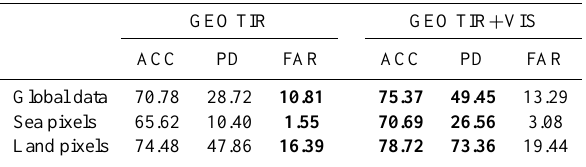
Table 3. Air quality monitoring results for GEO TIR and GEO TIR + VIS. For all the pixels of the red square domain (land and sea pixels together) in Fig. 2, the land pixels, and the sea pixels, we calculate the accuracy (ACC), the probability detection (PD) and the false alarm rate (FAR). See Sect. 3.2 for more details. Bold val- ues represent the best values in the comparison between GEO TIR and GEO TIR + VIS. GEO TIR GEO TIR + VIS ACC PD FAR ACC PD FAR Global data 70.78 28.72 10.81 75.37 49.45 13.29 Sea pixels